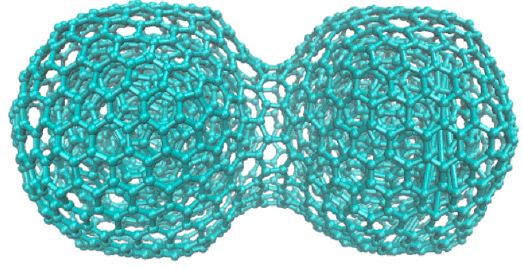
Figure 2. Carbon shell structure composed to mimic sucrose char behavior.